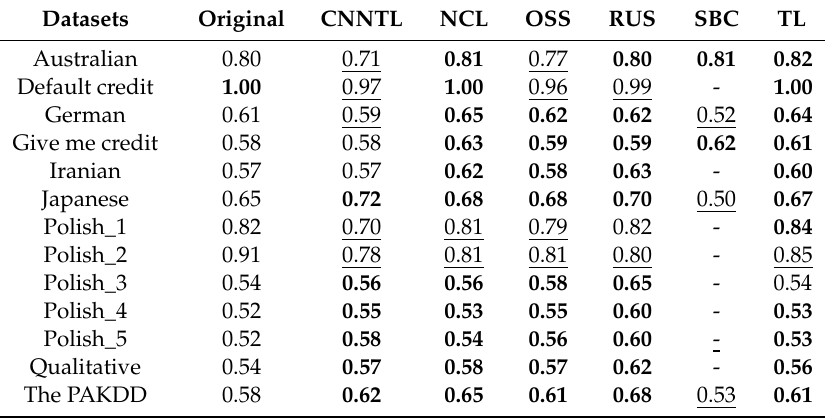
Table 19. AUC for SNDAM classifier after undersampling algorithms.